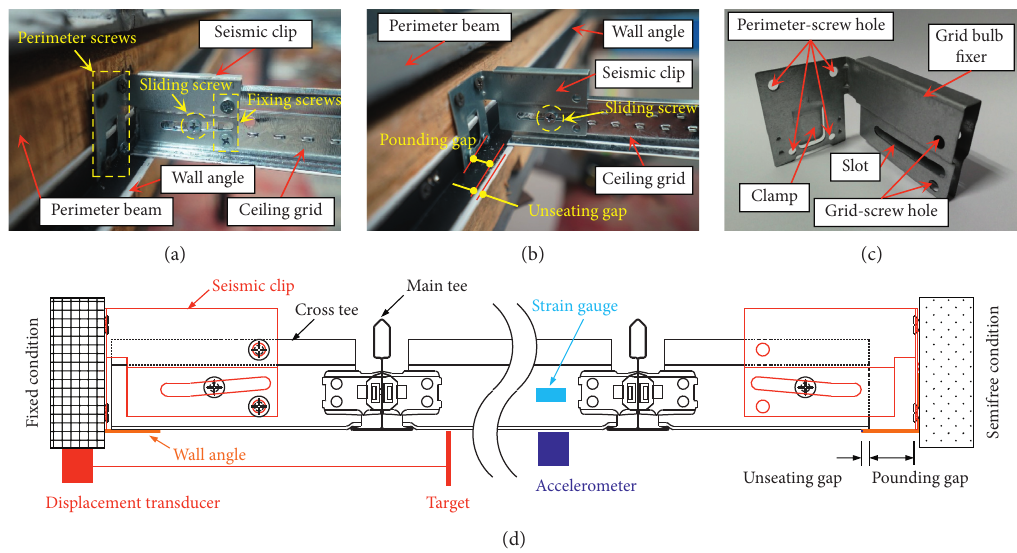
Figure 3: Seismic clip connection at boundary. (a) Fixed connection, (b) semifree connection, (c) seismic clip, and (d) details of connection.